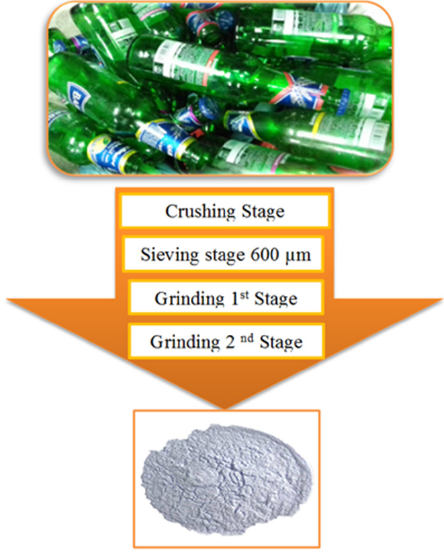
Figure 1. BGWNP production process.